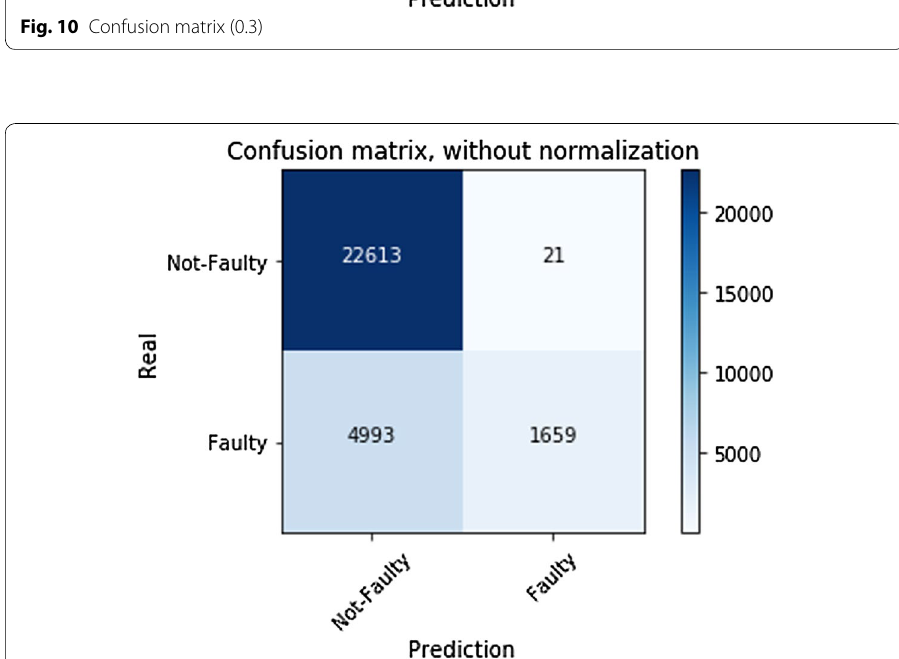
Fig. 11 Confusion matrix with